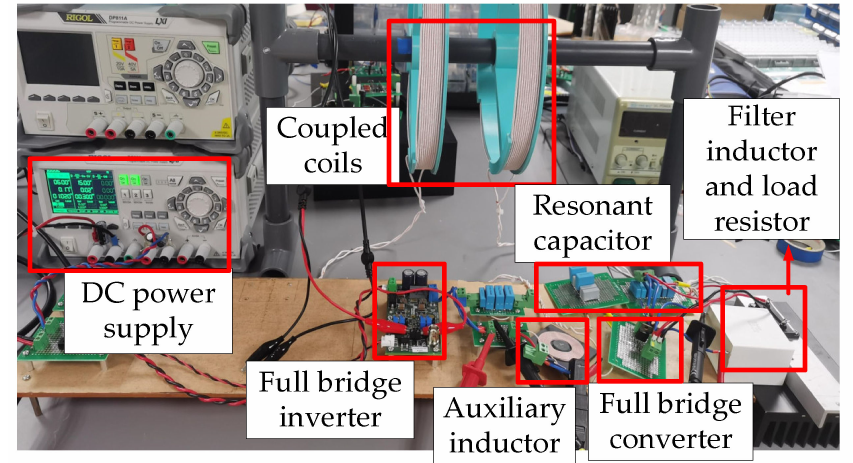
Figure 19. Photograph of the experimental